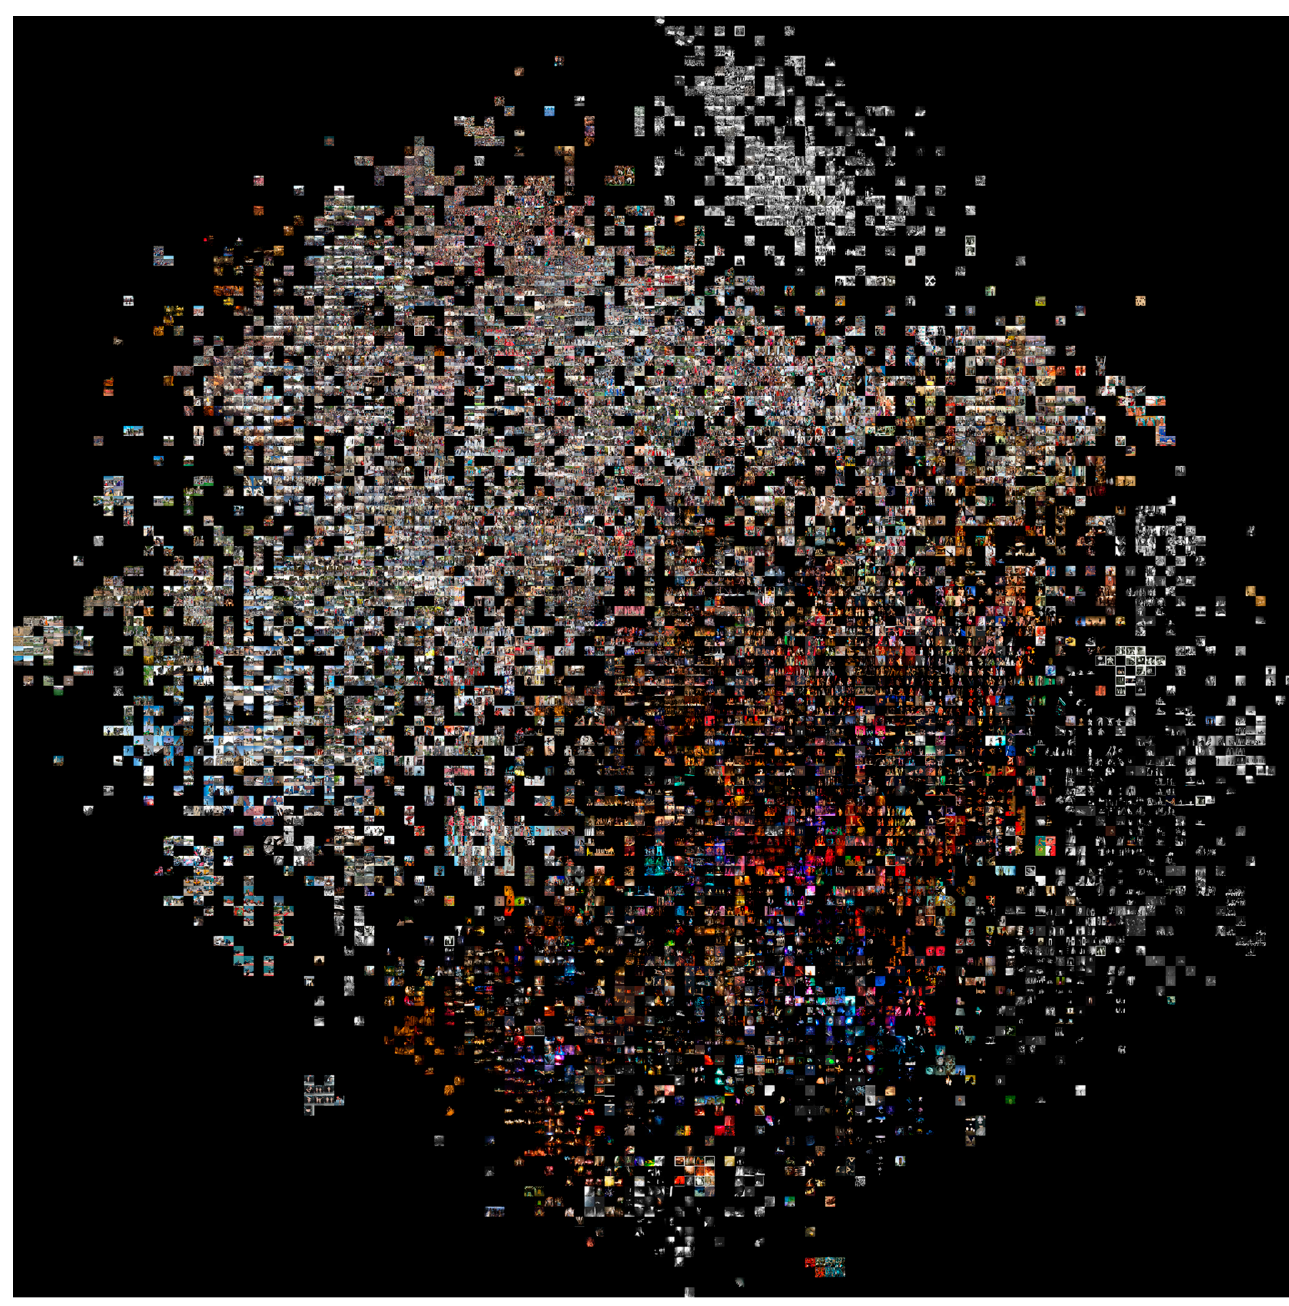
Figure 15 . Digital image containing 10,000 photographs regarding popular culture, ordered using the ResNet-50 convolutional neural network (2 × 2 m). © Pilar Rosado.